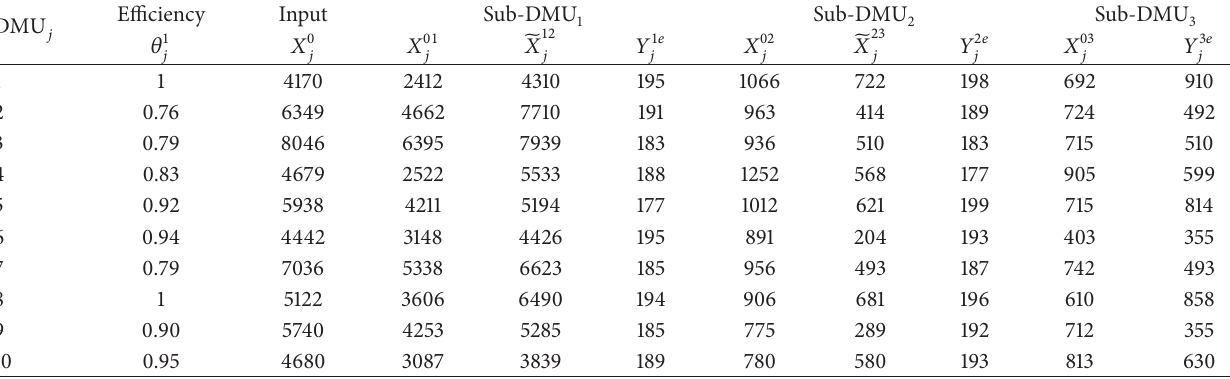
Table 1: Evaluation data of DN-DEA ( 𝑡 = 1 ).